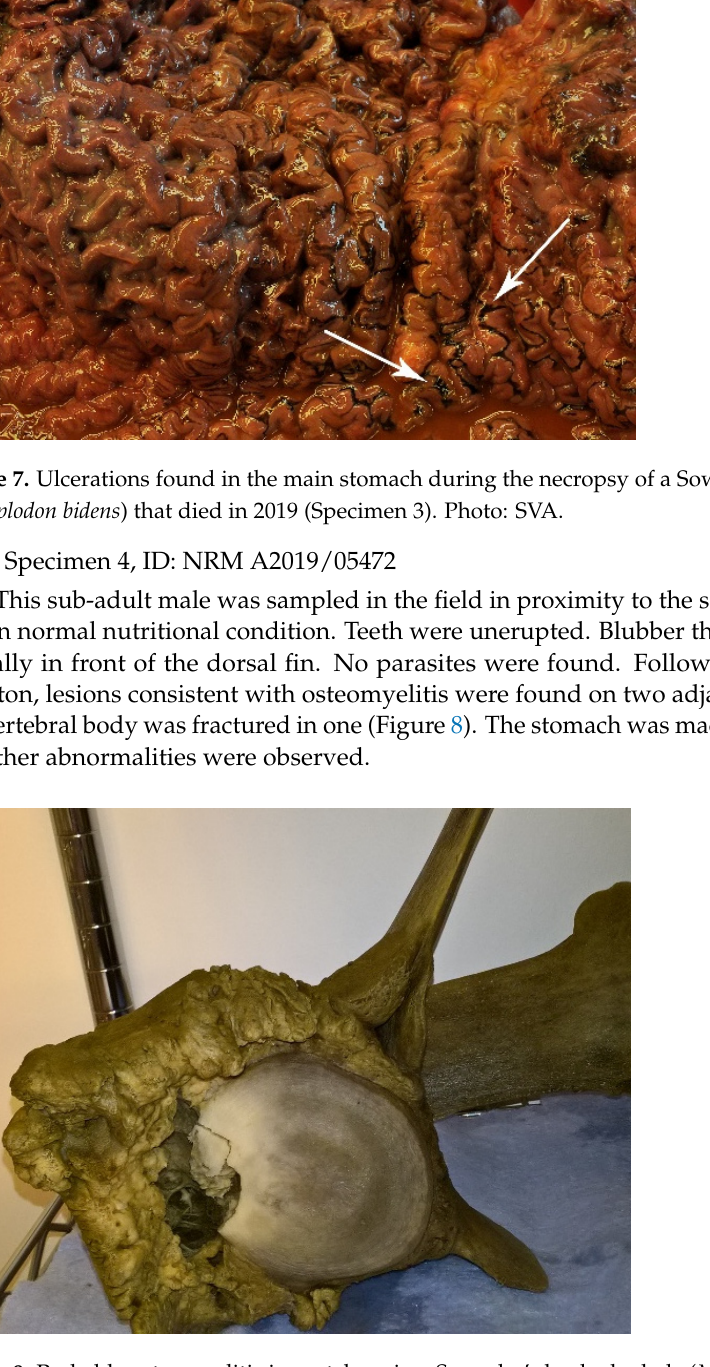
Figure 8. Probable osteomyelitis in vertebrae in a Sowerby’s beaked whale ( Mesoplodon bidens ) that died in 2019 (Specimen 4). Photo: Peter Nilsson, NRM.